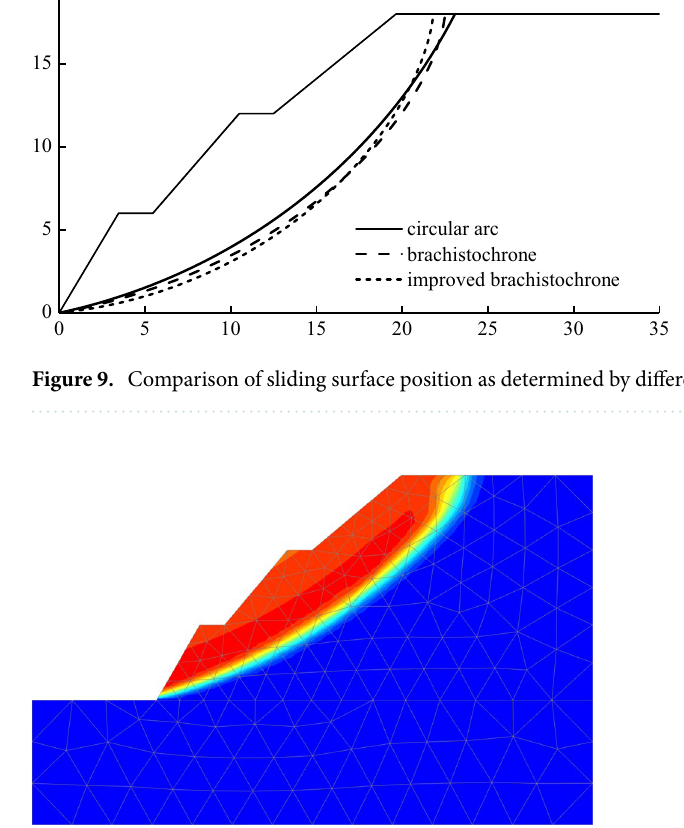
Figure 10. Incremental displacement nephogram of model.